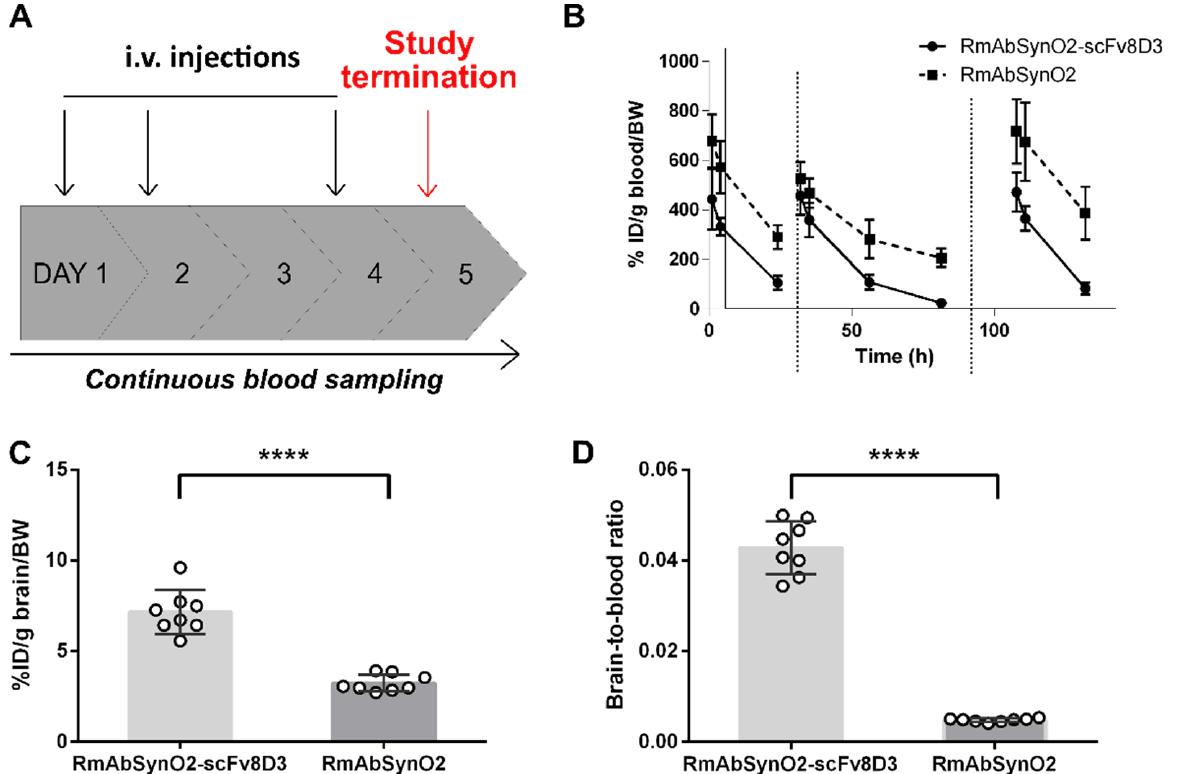
Figure 3. ( A ) Study design of a short-term treatment study in female L61 α SYN mice between 14-16 months of age. Mice were treated with i.v. injections 10 mg/kg RmAbSynO2-scFv8D3 or RmAbSynO2 or PBS ( n = 8 per treatment group) on day 1, 3 and 4, with study termination on day 5. ( B ) Lower blood exposure of [ 125 I]RmAbSynO2-scFv8D3 compared with [ 125 I]RmAbSynO2 at 1 h, 4 h and 24 h after each injection. ( C ) Higher concentration of [ 125 I]RmAbSynO2-scFv8D3 in the brain compared to [ 125 I]RmAbSynO2 (7.1 ± 0.43 and 3.2 ± 0.16%ID/g brain/bw, respectively) upon study termination. ( D ) Higher brain-to-blood ratio of [ 125 I]RmAbSynO2-scFv8D3 (0.043 ± 0.0021) in com- parison with [ 125 I]RmAbSynO2 (0.0048 ± 0.00013). All values are presented as means ± SD and ana- lyzed with an unpaired t -test. **** p < 0.0001.